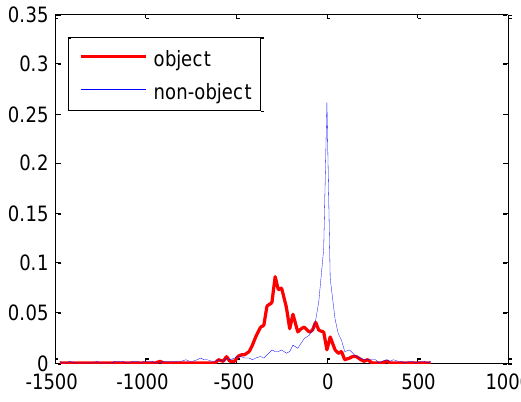
Figure 2. Example of feature value distributions. In [2] a single threshold that separates the two distributions is